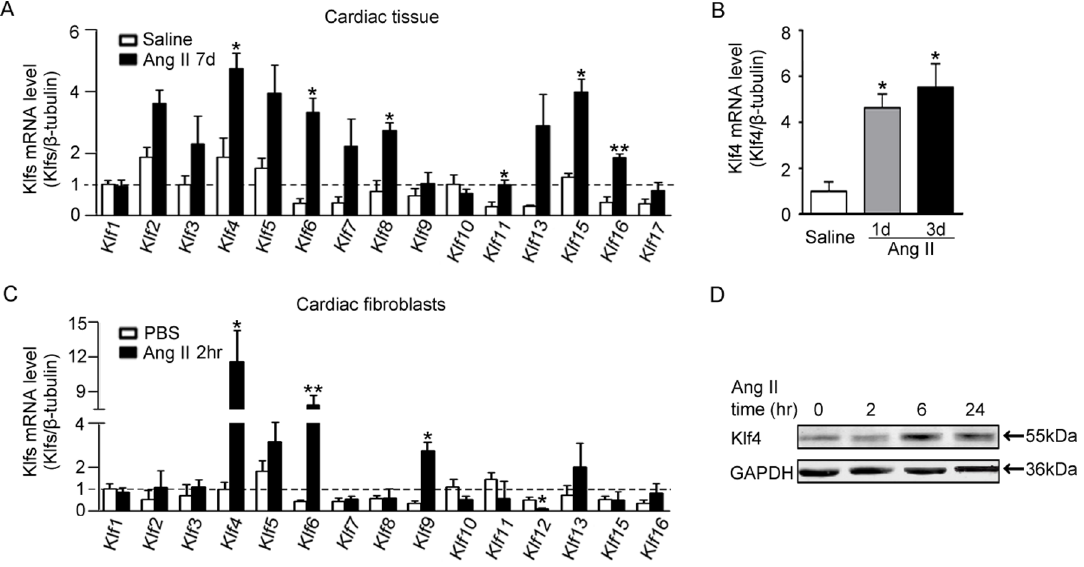
Figure 1. Klf4 expression is regulated in hearts in response to Ang II infusion. A, Klf mRNA levels in C57BL/6J wild-type (WT) hearts after 7 days of saline or Ang II infusion (1500 ng.kg 2 1 .min 2 1 ). mRNA levels were assessed by quantitative real-time PCR (qPCR) and normalized to b - tubulin. Klf12 and Klf14 were not detectable in hearts. Klf17 was not detectable in saline-infused hearts (n=3). B, qPCR of Klf4 mRNA levels in WT hearts after 3 and 5 days of Ang II infusion (n=3). Data are the mean 6 SEM. *P , 0.05 vs. saline-infused control. C, Klf mRNA levels in cardiac fibroblasts after 2 hrs of stimulation with PBS control or Ang II (1 m mol/L). Klf14 and Klf17 were not detectable in cardiac fibroblasts (n=3). D, Western blot of Klf4 protein levels after Ang II treatment. GAPDH was the loading control. Data are the mean 6 SEM. *P , 0.05, **P , 0.01 vs. PBS control.